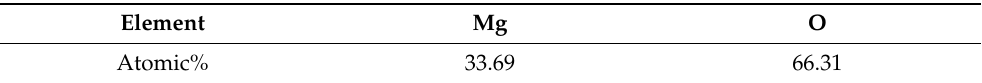
listed in Table 2. The ratio of Mg:S:O was 4.86:1:15.26, which was slightly lower than that obtained via EDS